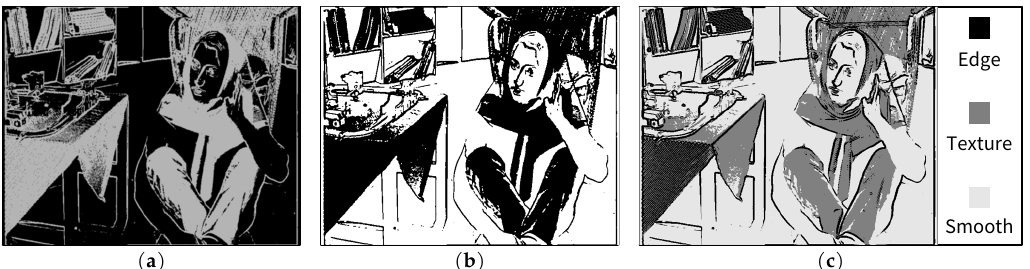
Figure 8. Texture information of the BARB image in the proposed scheme; ( a ) visualization of contrast activity (treated as grey values and multiplied by 20 for visibility); ( b ) high contrast activity (black) regions after thresholding with T A = 5; and ( c ) final edge, texture and smooth